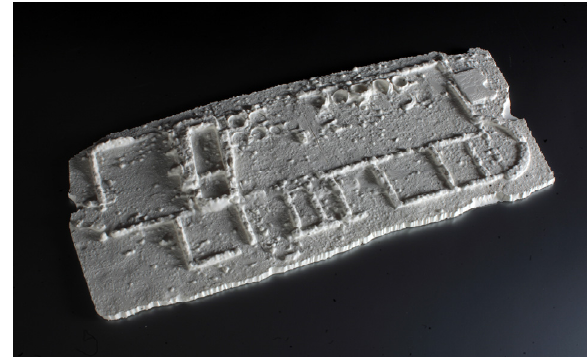
Figure 9: The 3D printed model of the sunken roman